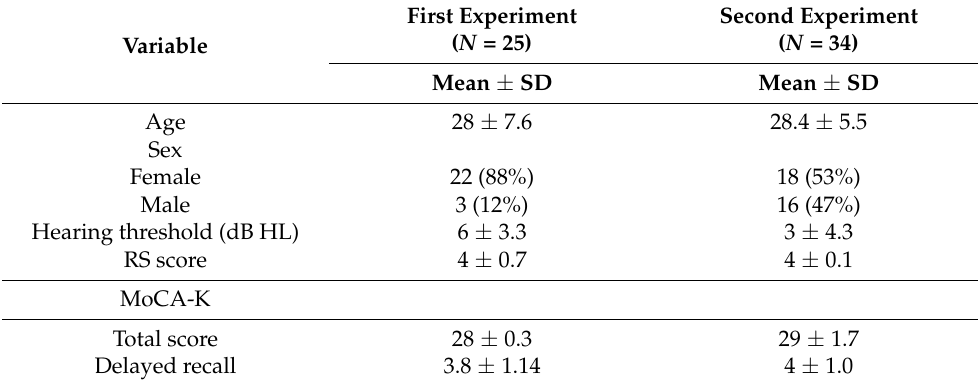
First Experiment ( N =